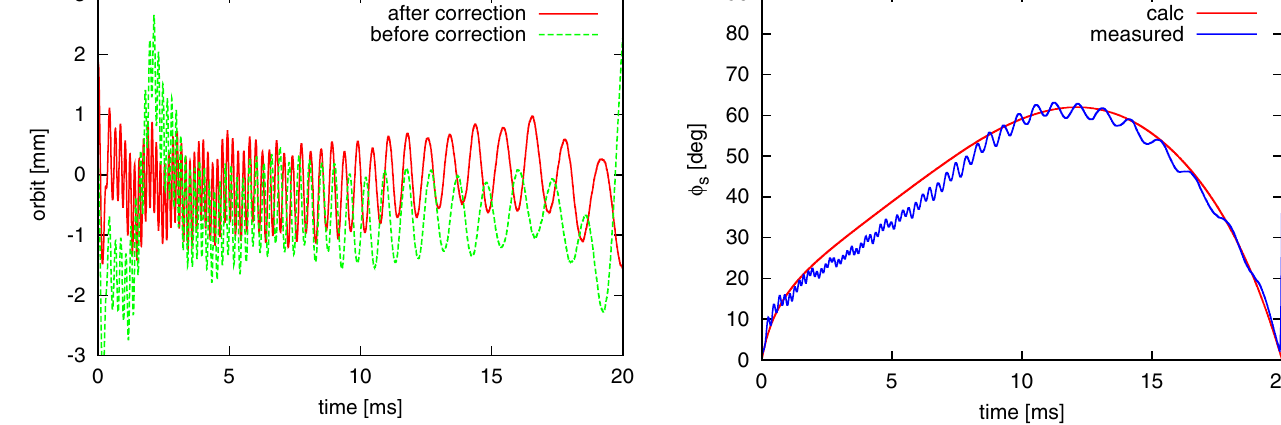
FIG. 20. (Color) Synchronous phase measured for the rf voltage shown in Fig. 21 over the acceleration time, where the blue curve is the measured one, and the red curve the calculated one assuming that the rf voltage is a pure sine wave.